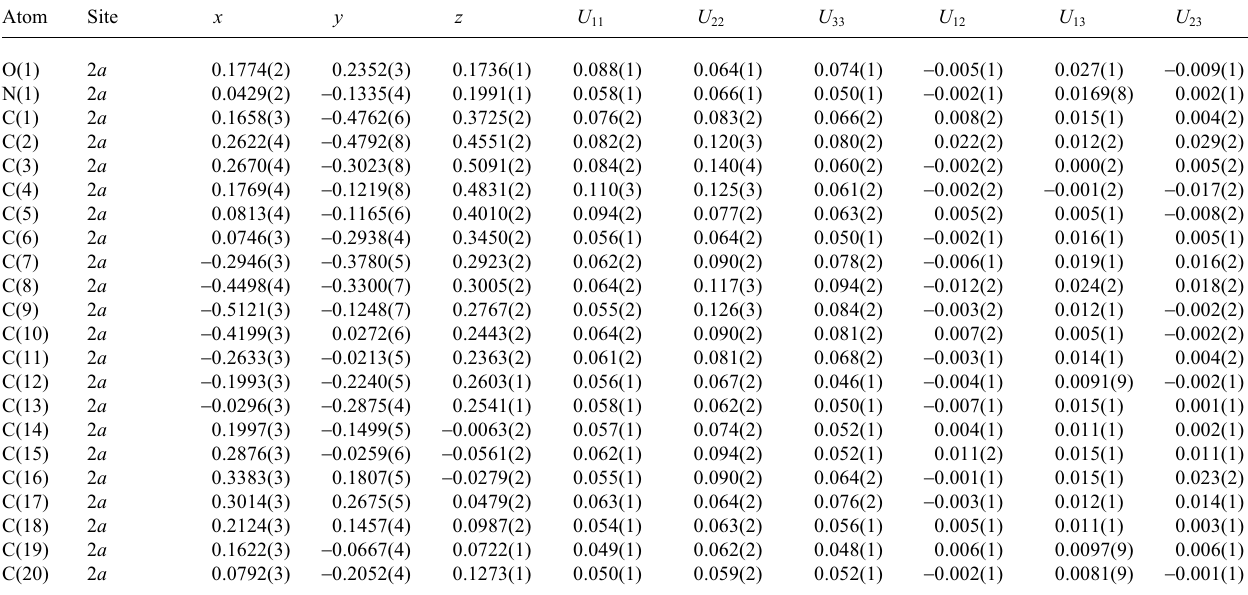
Table 3. Atomic coordinates and displacement parameters (in Å 2